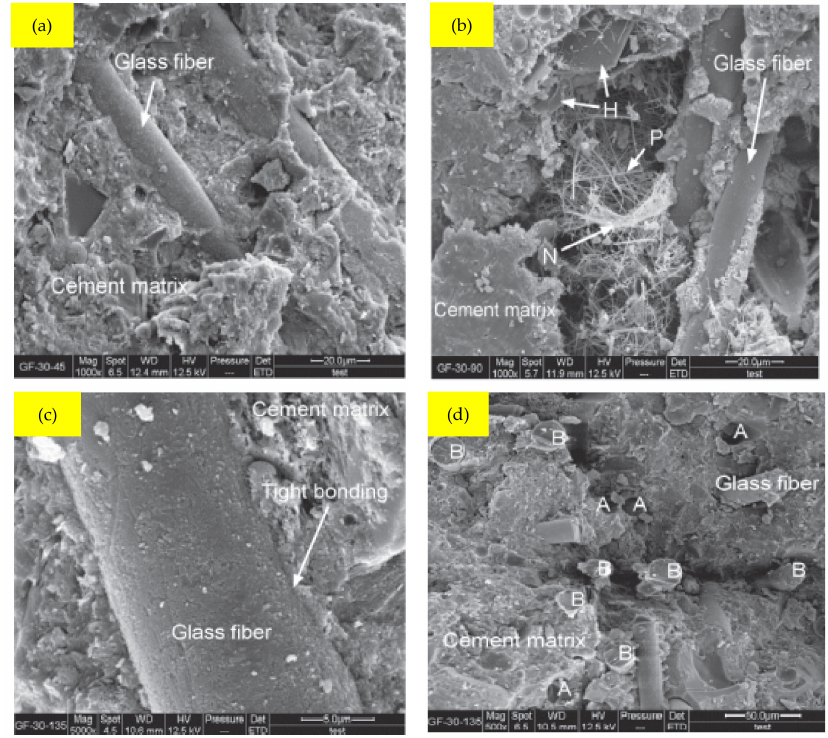
Figure 14. SEM Results of GF at Water to Binder Ratio 0.30: Used with the Permission of Elsevier